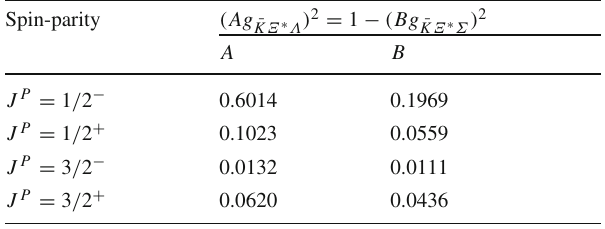
Table 2 Relations between the coupling constants g ¯ Spin-parity